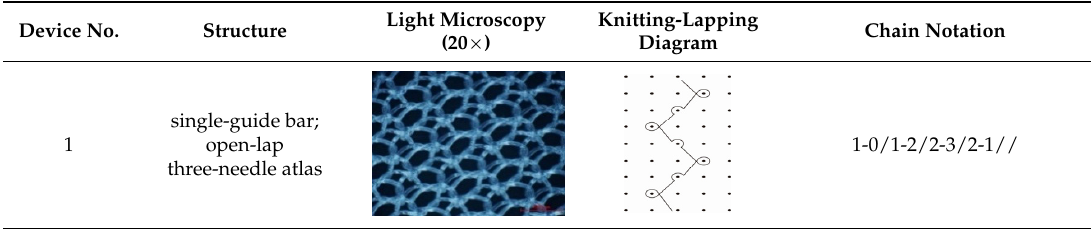
Table 2. Loop structures and knitting-lapping diagrams.